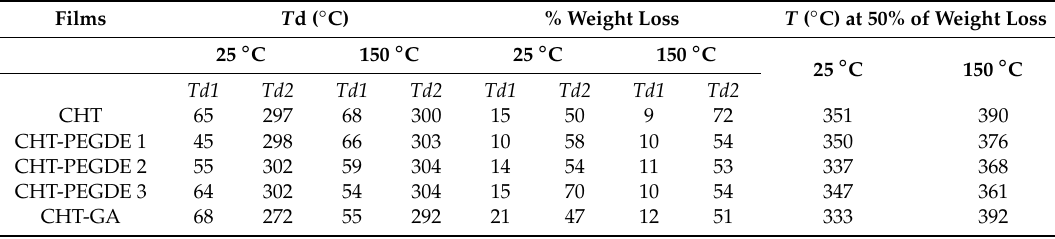
Table 2. Maximum temperatures and weight loss of CHT films dried at 25 ◦ C and 150 ◦ C.